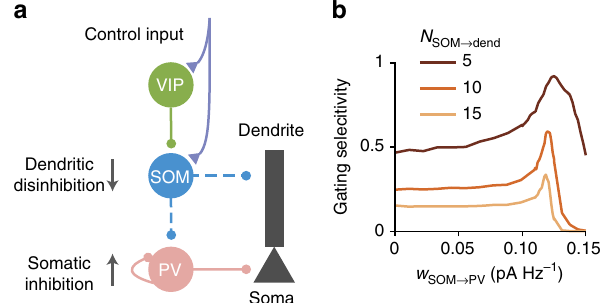
Figure 6 | Somatic inhibition improves gating selectivity. ( a ) PV neurons project to the somatic areas of pyramidal neurons, and are inhibited by SOM neurons and themselves. Suppression of SOM neurons causes disinhibition of PV neurons, therefore an increase in somatic inhibition onto pyramidal neurons. ( b ) A moderate increase in somatic inhibition always improves gating selectivity. We included PV neurons and their corresponding connections in the model of Fig. 5d. Gating selectivity increases as a function of the SOM-to-PV connection weights ( w SOM - PV ) in a wide range (see Supplementary Note 1 for a proof). However, when gating selectivity is low without PV neurons (light curve), the peak of this increase is lower and the slope is sharper. Gating selectivity starts to decrease when the SOM-to-PV connection, therefore the somatic inhibition, is too strong that the responses of many pyramidal neurons are completely